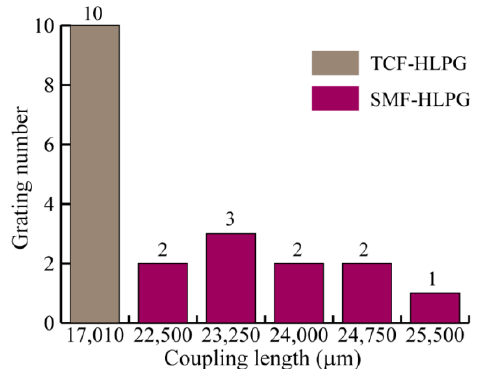
Figure 12. The coupling lengths of the TCF-HLPG and the SMF-HLPG samples.